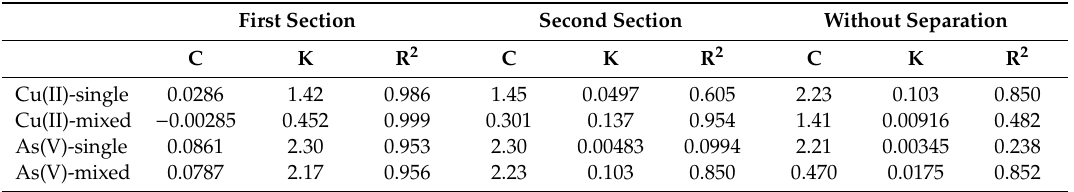
Figure 7. Weber and Morris intraparticle diffusion model with two sections. Table 3. Di ff usion parameters for the Weber and Morris intraparticle model for Cu(II) and As(V) in single and mixed